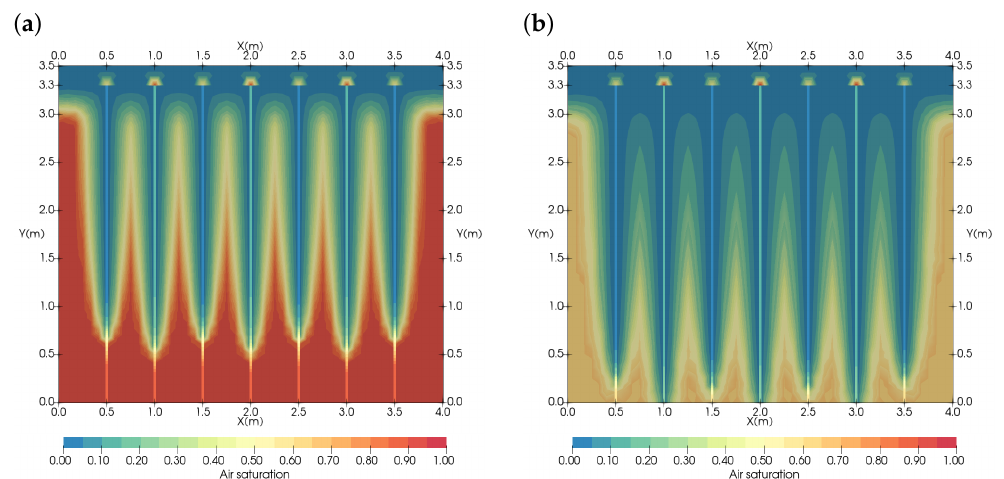
Figure 16. Air distribution in model TUFF2D after three hours corresponding to a low precipitation rate scenario (case A). ( a ) low initial water saturation, ( b ) high initial water saturation. For the high rainfall intensity (Case B), the front moves much faster through the initially dry model TUFF2D, reaching the same infiltration depth as in the low-intensity Case A in just 10 min Figure 17a. Now, the water penetrates the mm-wide fractures multiple times faster than the narrower ones. The wetted fracture matrix halos are correspondingly narrower spanning only about 35% of the total model area. At this early time in the evolution, less air has a chance to leak out into the soil layer through the fracture system.